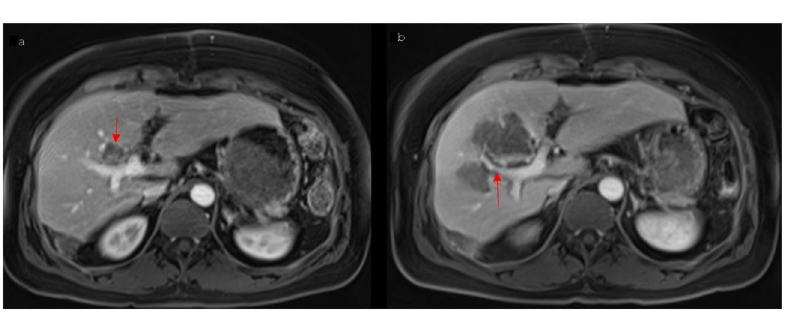
Figure 2. A 64-year old man with a centrally located HCC. ( a ) Pre-interventional Gd-EOB- DTPA-enhanced T1 vibe 3d fat suppressed magnetic resonance imaging in delayed phase shows a centrally located HCC (arrow) next to the portal vein encasing a bile duct. ( b ) The corresponding portal venous phase shows a freely perfused right branch of the portal vein. ( c ) 6 weeks after IRE contrast-enhanced T1 vibe 3d fat suppressed magnetic resonance imaging in portal venous phase shows a newly occurred partial thrombosis (arrow) of the right portal vein.